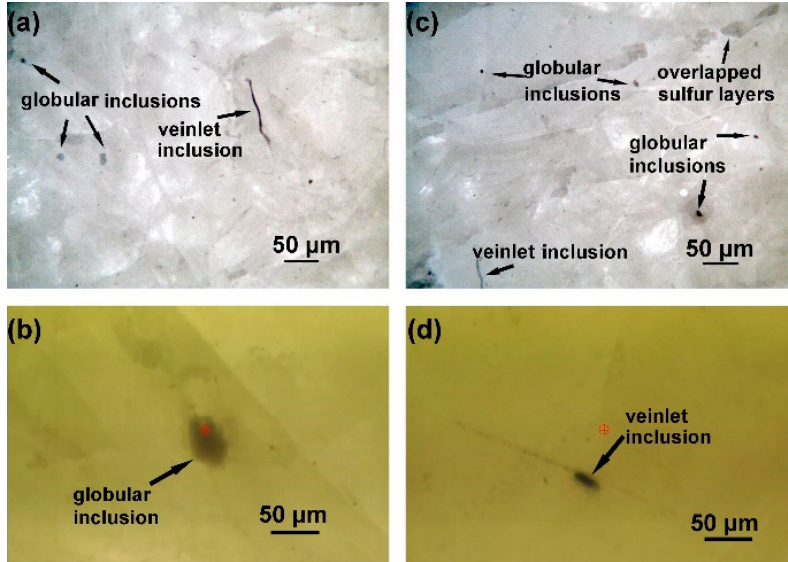
Figure 3. Microscopy images of native sulfur, and inclusions, from a moderate temperature (about 100 °C) vent at the Kueishantao hydrothermal area. ( a ) and ( c ) are transmitted light microscopy images; ( b ) and ( d ) are reflected light microscopy images. The red circles with crosshairs shown in ( b ) and ( d ) represent inclusions found in samples.